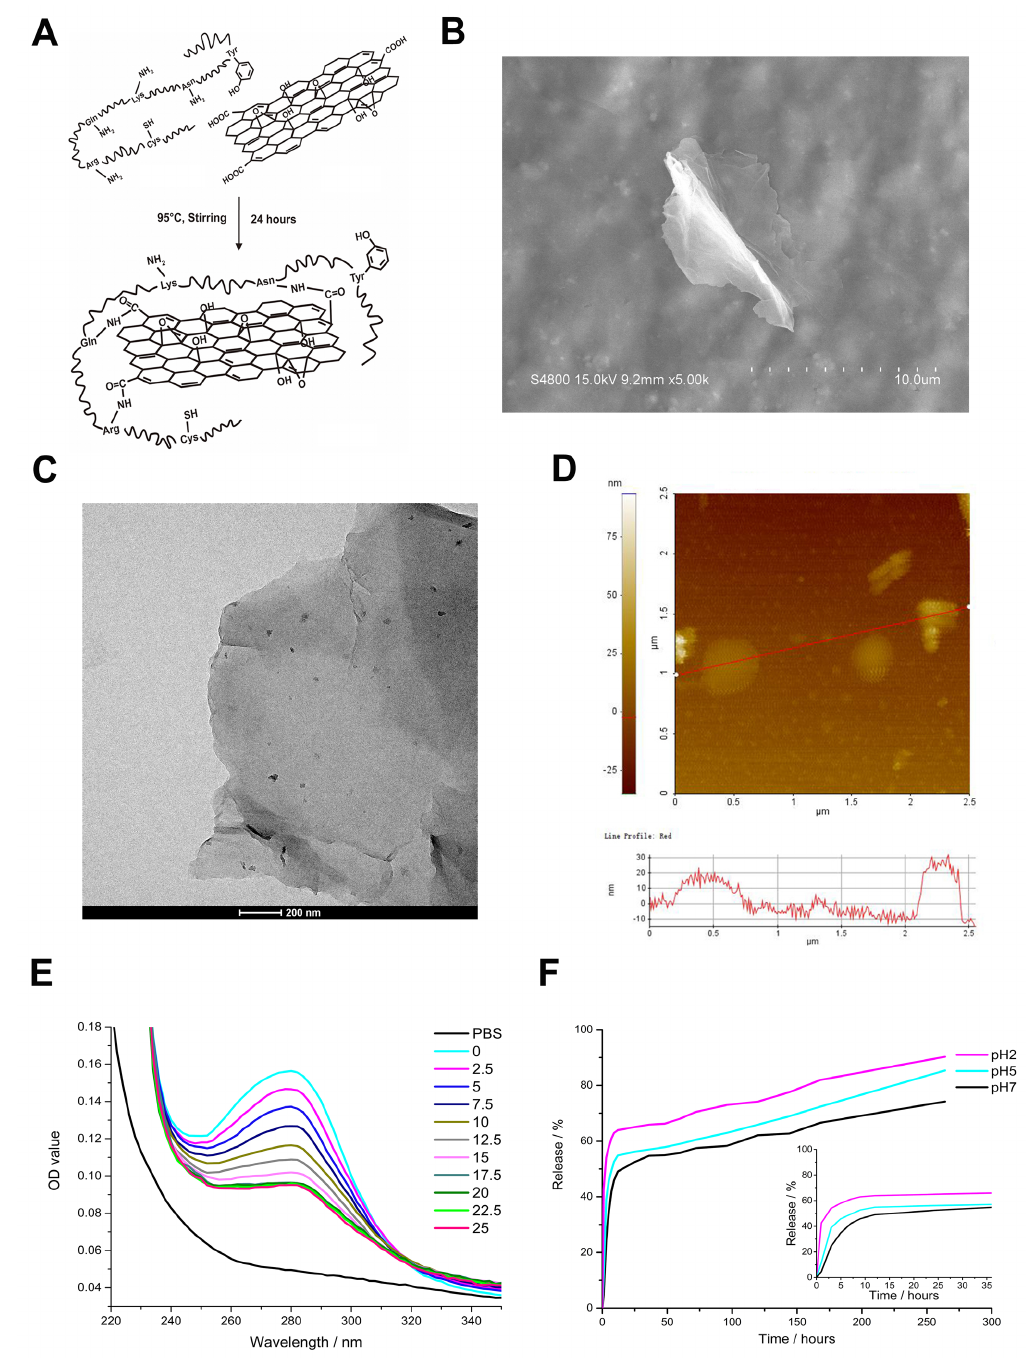
Figure 2. The nanocarrier function of gelatin reduced graphene oxide (rGO@Ge). ( A ) The schematic diagram of the rGO@Ge synthesis. The scanning electron microscopy (SEM) ( B ), transmission electron microscopy (TEM) ( C ) and atomic force microscopy (AFM) ( D ) detections showed the surface morphology of rGO@Ge. (reprinted with permission from Ref. [22]. Copyright 2021 American Chemical Society). ( E ) The loading curves of the different amounts of rGO@Ge mixed with the same amount of KGN. ( F ) The KGN releasing kinetic curves of the KGN-loaded rGO@Ge in different pH